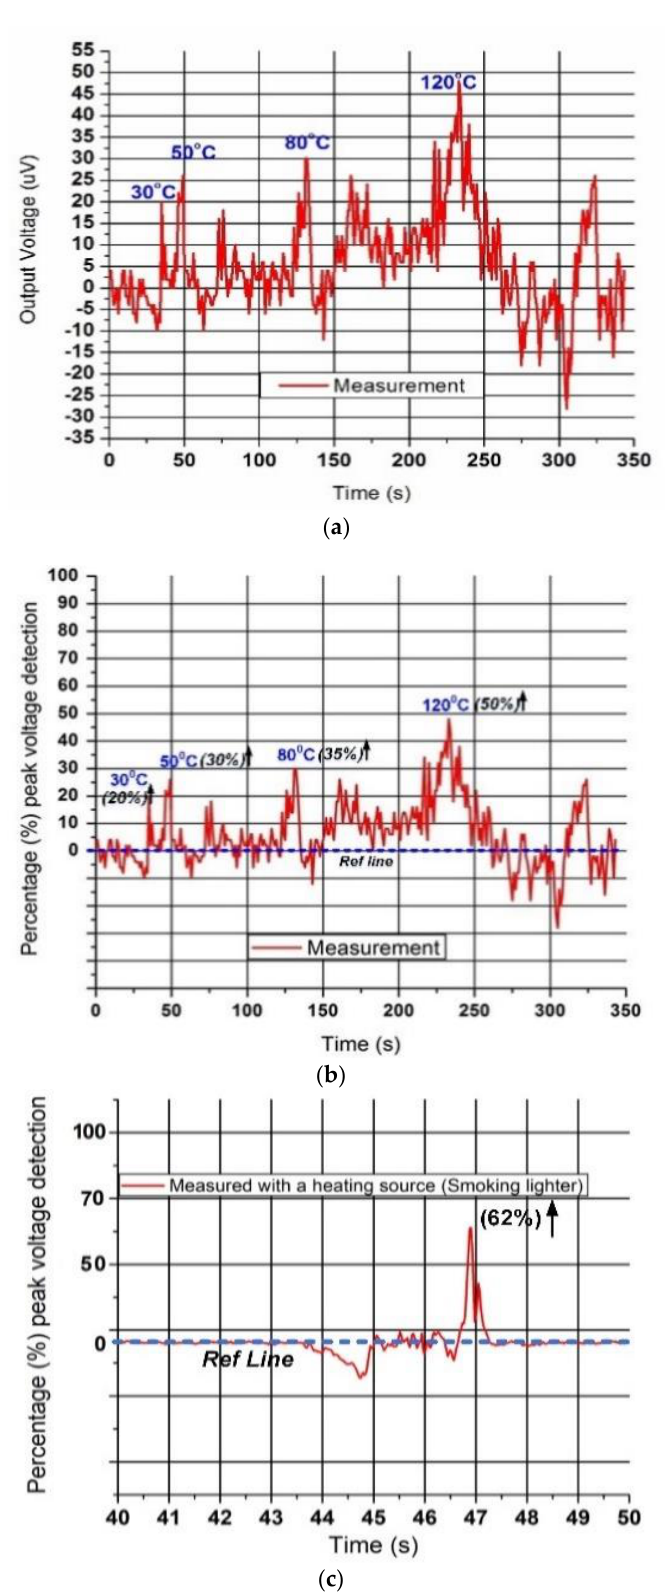
Figure 7. Peak voltage detection by thermal heating measurements. ( a ) Results of quick uniform thermal heating (µV); ( b ) percentage peak voltage detection of ( a ); ( c ) percentage voltage detection of a single thermoelectric junction tested with a switch-off smoking lighter, approximately 60 °C at 1 cm of distance.